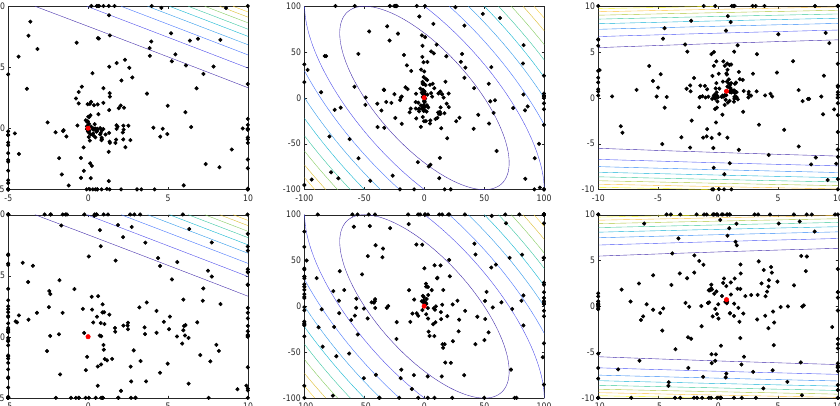
Figure 3. Search maps of search agents when solving functions f 9 , f 10 , and f 12 ; by the ESCA algorithm ( first row ); and the SCA algorithm ( second row ).